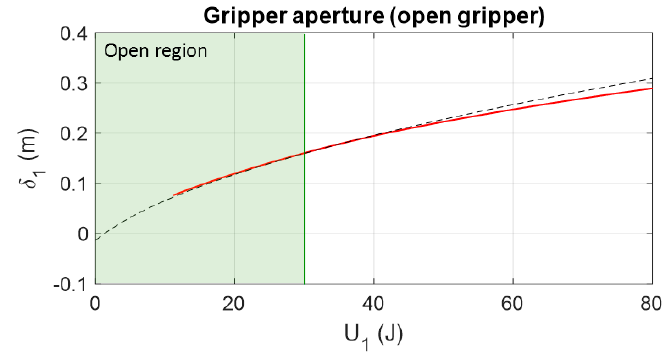
Figure 22. Comparison between the theoretical and simulated gripper aperture (measuring the value of L 21 ) and the energy of actuator 1. At 30 J or 0.16 m, the gripper closes, increasing the error between the theoretical and simulated results.